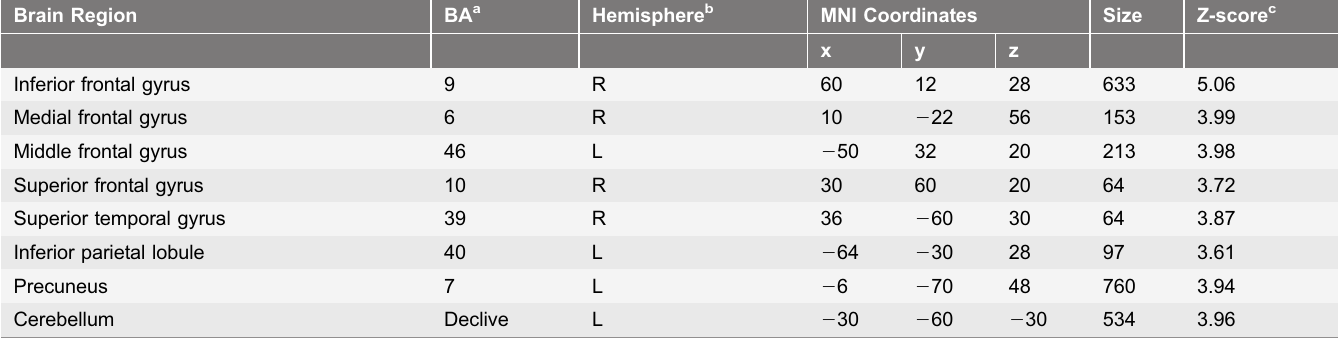
a Brodmann areas. b L 5 left, R 5 right.